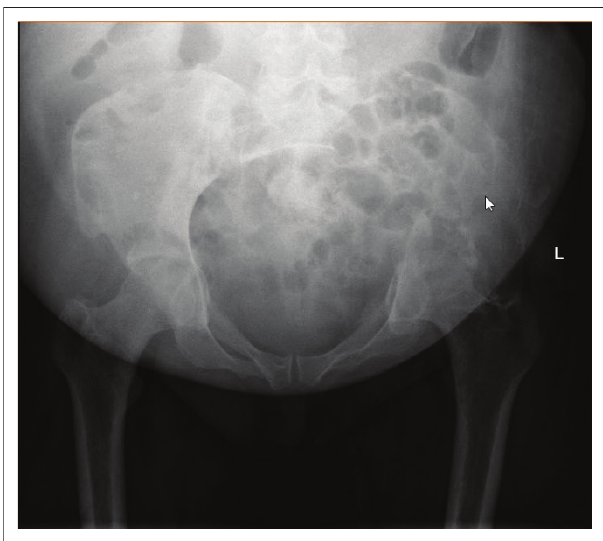
FIGURE 1: An X-ray demonstrated an absent left hemipelvis.